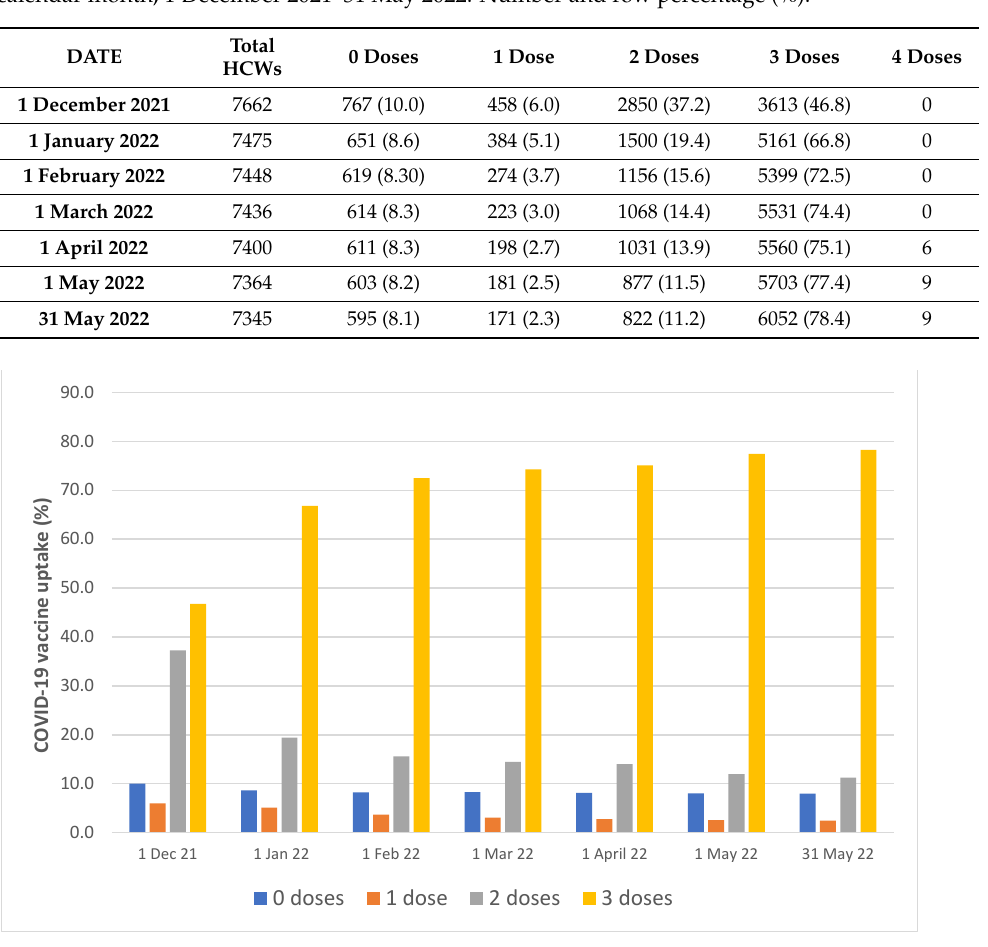
Figure 1. COVID-19 vaccine uptake (%), by number of doses and calendar month (1 December 2021 – 31 May 2022).